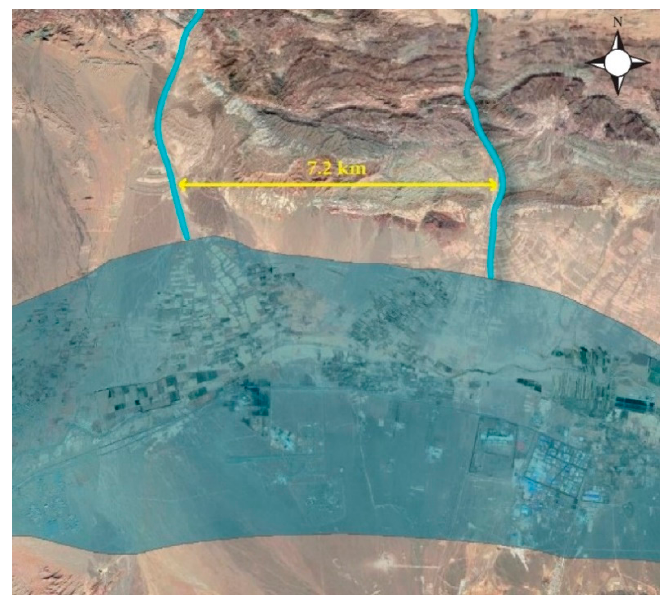
Figure 12. Alluvial fans position at the northern boundary of the Birjand aquifer. The blue line shows the groundwater lateral recharge way.